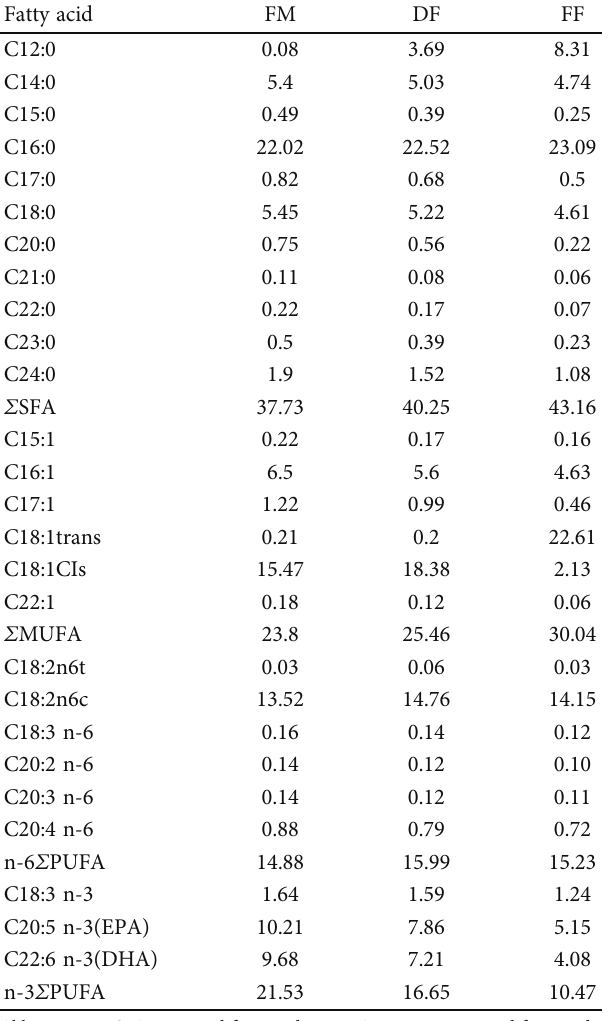
Table 3: Fatty acid composition of three experimental diets (% total fatty